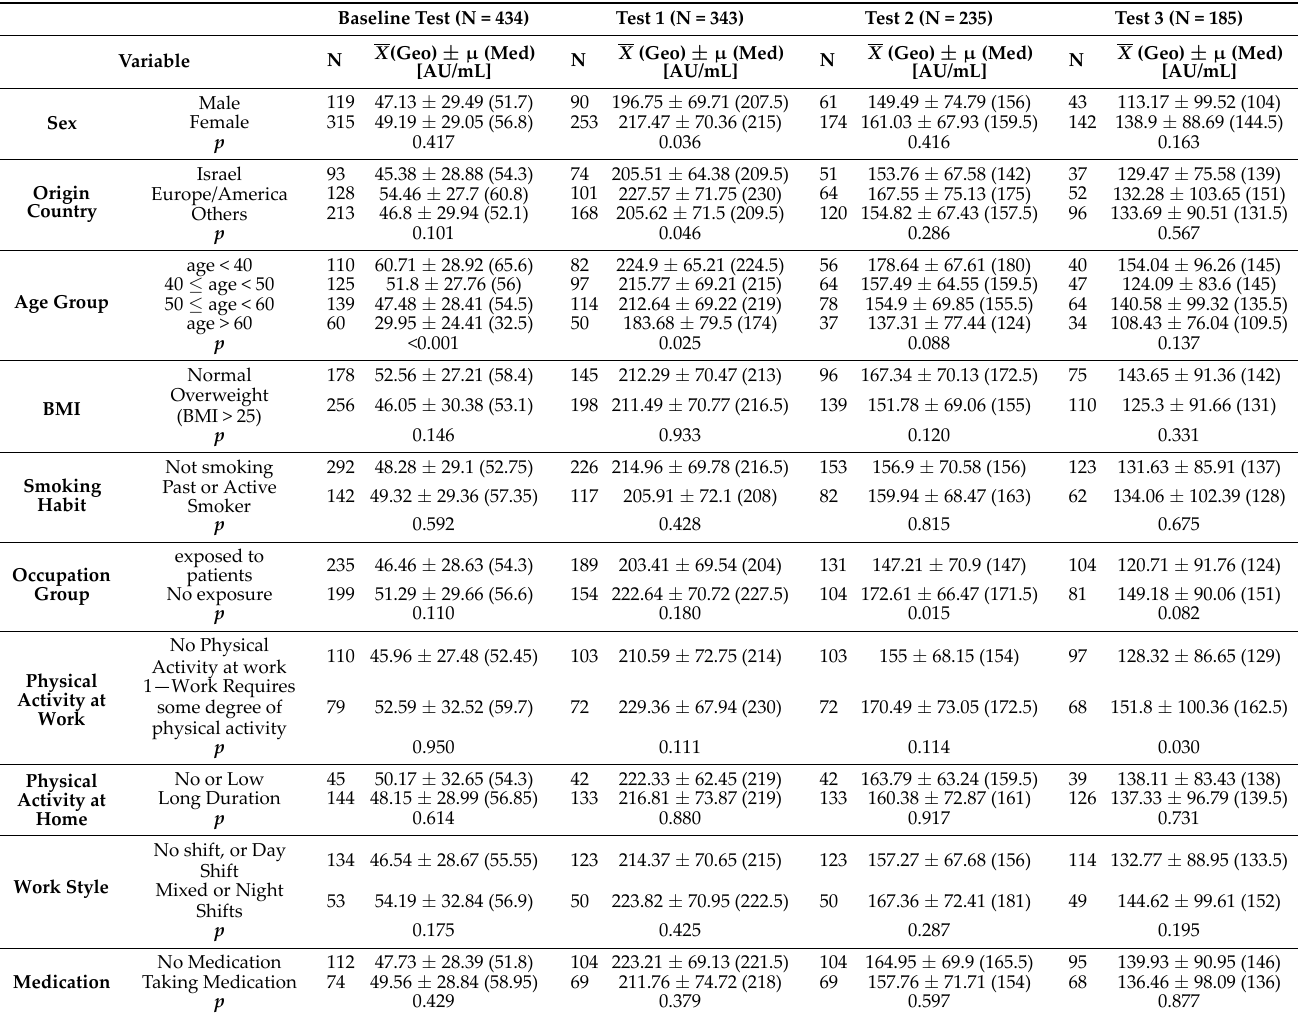
Table A1. Univariate association between anti‑S levels and sociodemographic variables. Data calcu‑ lated for participants tested at this test were not positive for COVID‑19 exposure at the test or any time